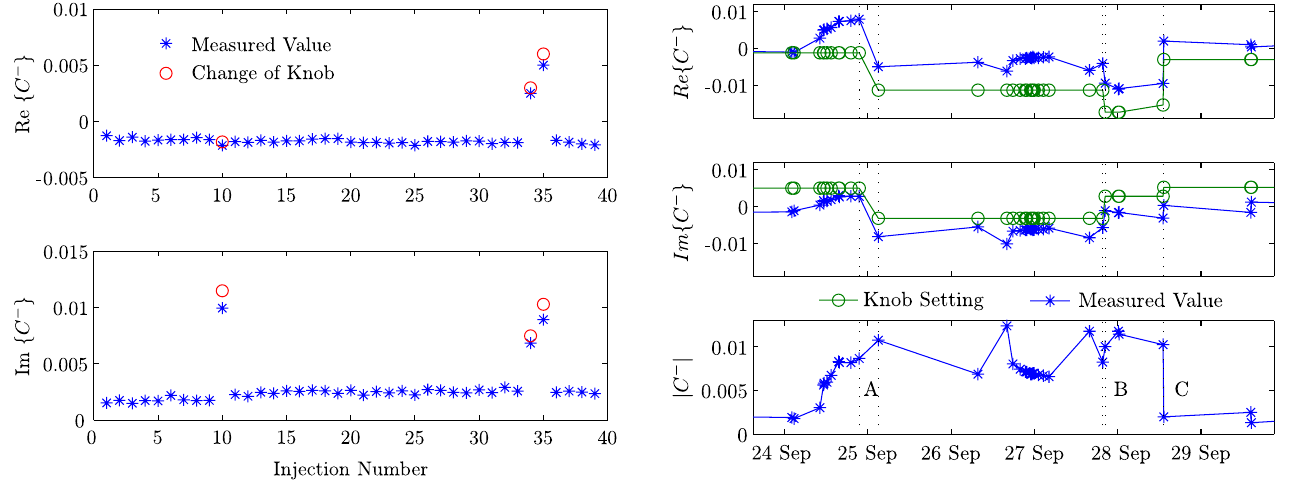
measured.FIG. 5. Measured C − for different injections during 6 h. The blue stars shows the setting, in the model, of the coupling knobs which best reproduce the measured coupling. The red circles show the strength of the three manual changes that were applied.